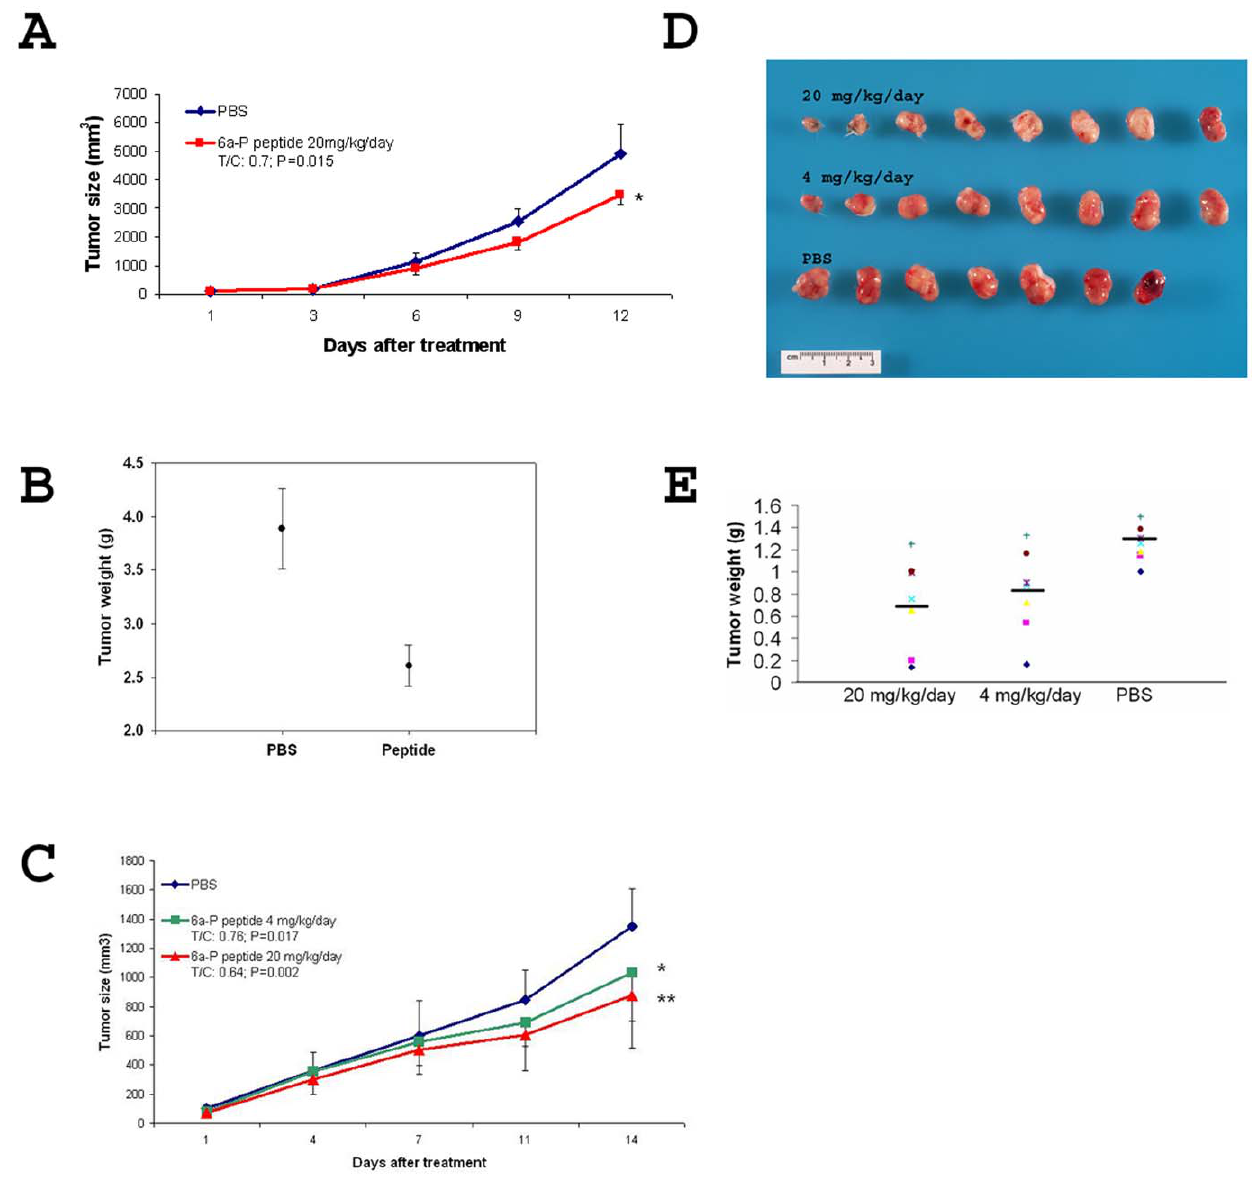
Figure 4. Angiogenesis and mouse LLC tumor growth are suppressed by 6a-P peptide invivo . Two different tumor-bearing animal models were employed for anti-tumor study. The mice were treated with the peptide or PBS twice a day after tumor cells injection. In mouse LLC animal model, the tumor sizes are decreased about 30% after the treatments (n=5) (A). However, the tumor weights show about 40% different between treated or non-treated groups (B). Human liposarcoma animal model shows the tumor sizes are decreased about 36% in high dose treated group (C). Less hemorrhage (as shows in red on tumor surface) is observed in the high dose of peptide treated despite similarities in tumor sizes for treated and untreated mice (D). The tumor weights show a difference of 2-fold following treatment (n=8)